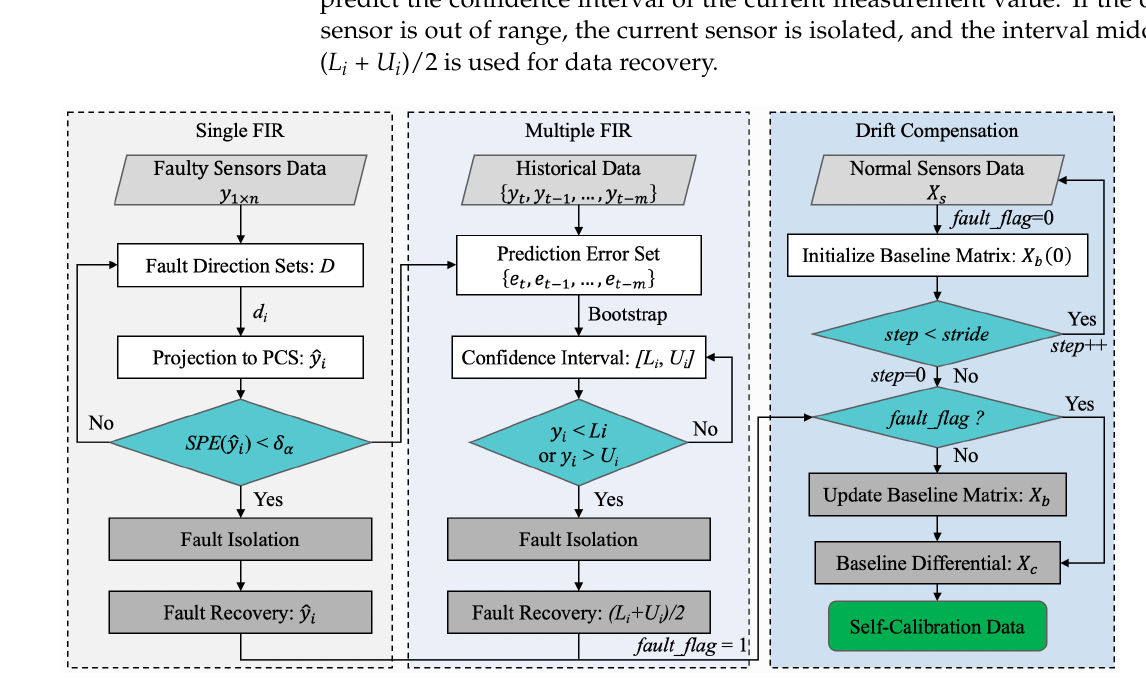
Figure 5. Flowchart of Self-Calibration.